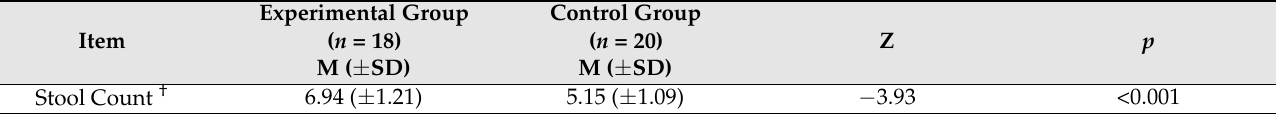
Table 4. Between Groups Differences Test for Stool Count ( n =